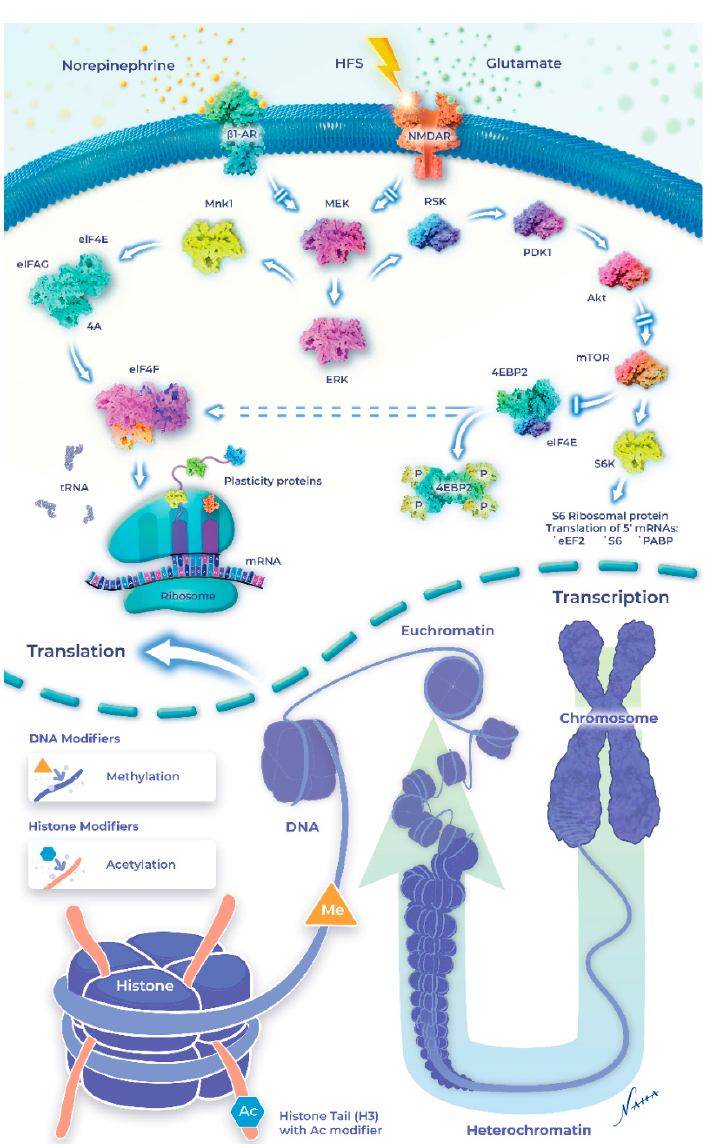
Figure 2. Signaling pathway linking beta-adrenergic receptors to regulation of the epigenome.